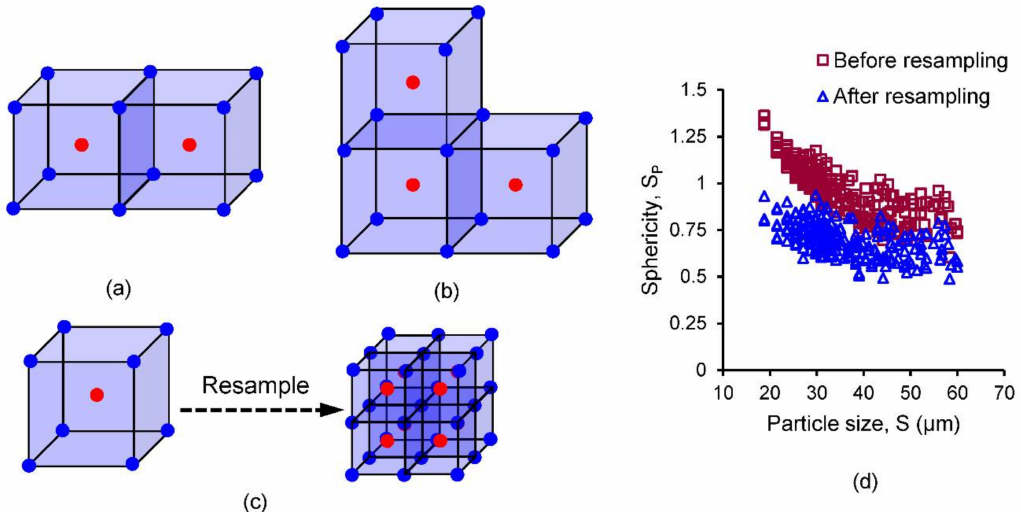
Figure 3. Reasons of erroneous morphological parameters and the proposed solutions: ( a ) voxel centroids on a single line; ( b ) voxel centroids on a single plane; ( c ) resampling; ( d ) comparison of sphericity results for 64 MPa (red and blue circular markers represent voxel centroids and voxel corners respectively).